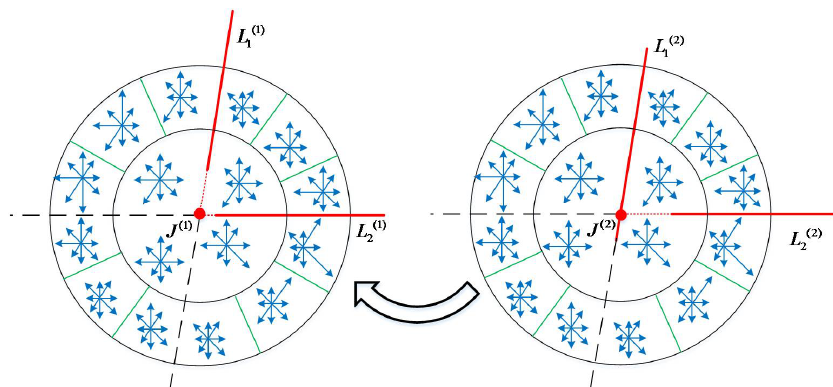
Figure 5. LJL descriptor construction and matching. Two red line segments intersect at red dot as a LJL structure, and two black circles define the sub-regions together with green lines. The blue arrows (8 arrows in one cluster) represent the descriptor in each sub-region.